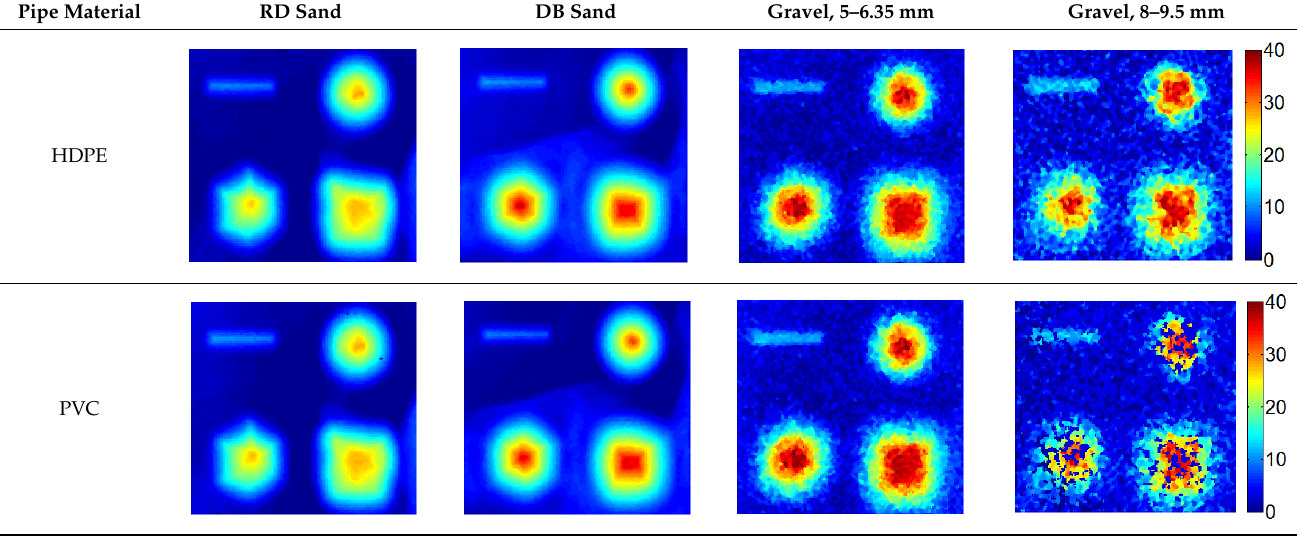
Table 5. Void areas in mm 2 for detected voids in Table 4.